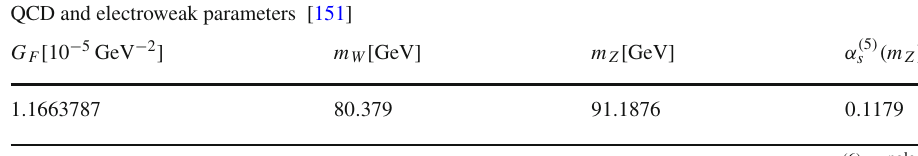
Table 2 Summary of the input parameters used throughout this work. For convenience, the derived values of the MS running parameters evaluated at the scale μ t = m pole t are also given. In the Wolfenstein parametrization [152] of the CKM matrix, the four independent Wolfenstein parameters can be chosen as λ , A , ¯ ρ = ρ( 1 − λ 2 / 2 ) , and ¯ η = η( 1 − λ 2 / 2 ) [153]